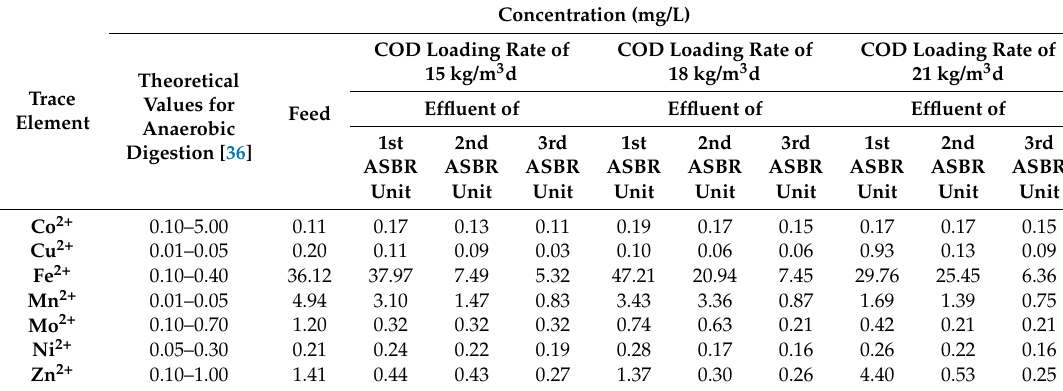
Table 2. Micronutrient concentrations in the three-stage ASBR system operated at 37 ◦ C at different COD loading